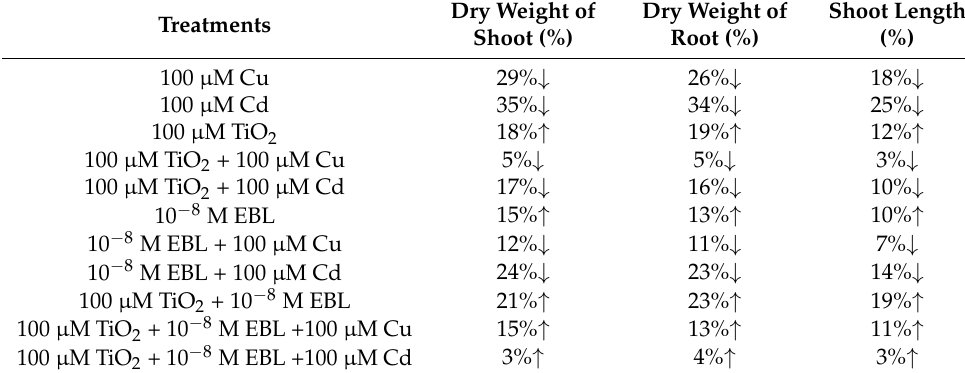
Table 4. The changes in bamboo biomass in root and shoot dry weight as well as shoot length with 24-epibrassinolide and titanium oxide nanoparticles individually or combined with 100 µ M Cu and 100 µ M Cd in comparison with the control